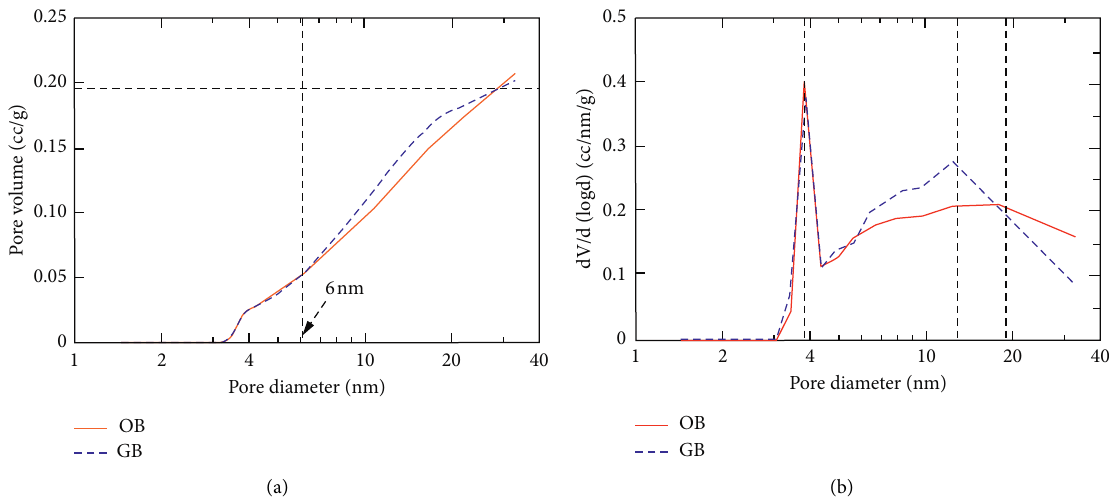
Figure 12: PSD of original and granular bentonites by NA. (a) Cumulative pore volume and (b) PSD density.